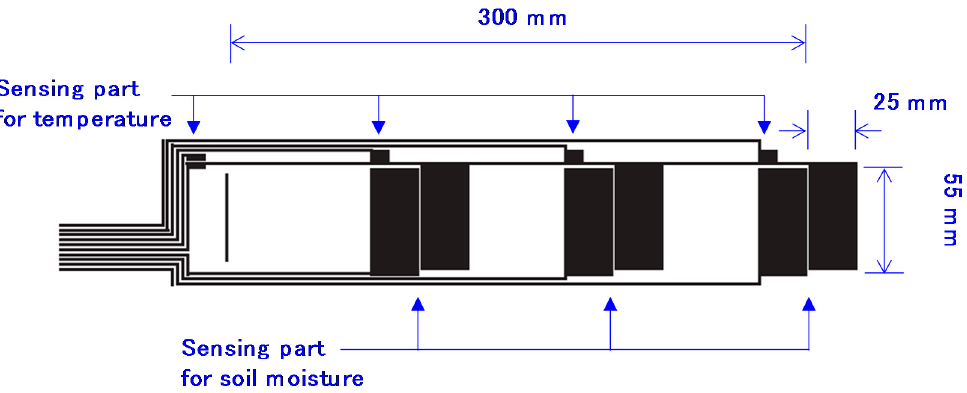
Figure 1. Schematic of copper circuit printed on the film substrate.